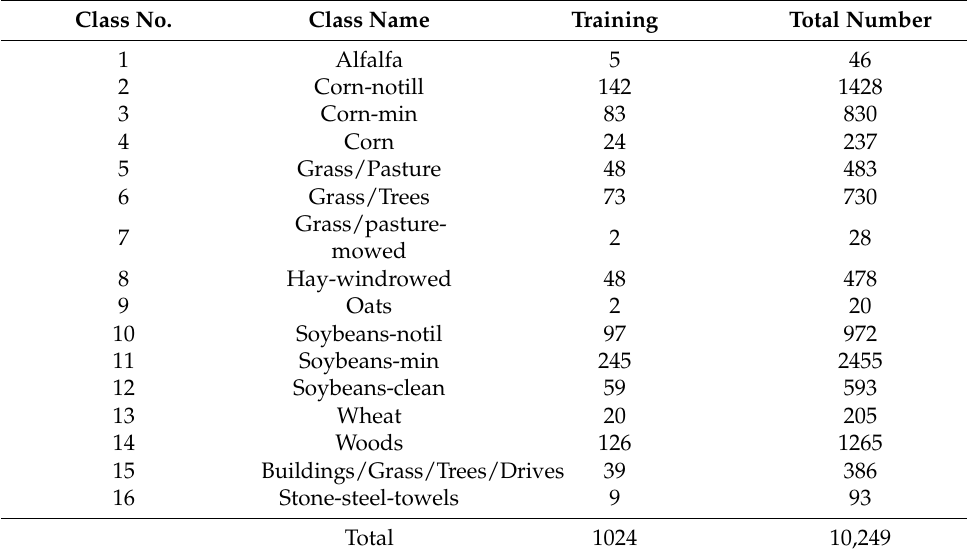
Table 3. Land-Cover Classes of The Indian Pines Data Set Class